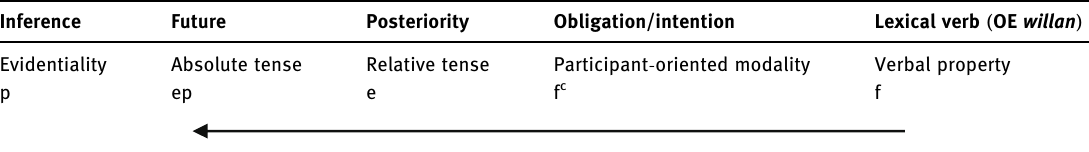
Table 1: Development of English will in FDG ( Keizer and Olbertz 2018, 10, see also Hengeveld 2011, 593